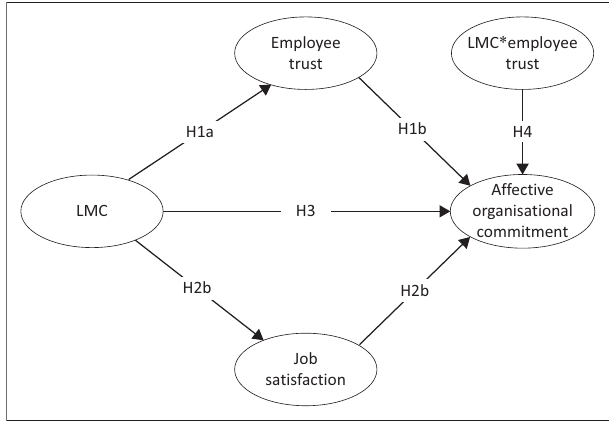
FIGURE 1: Conceptual